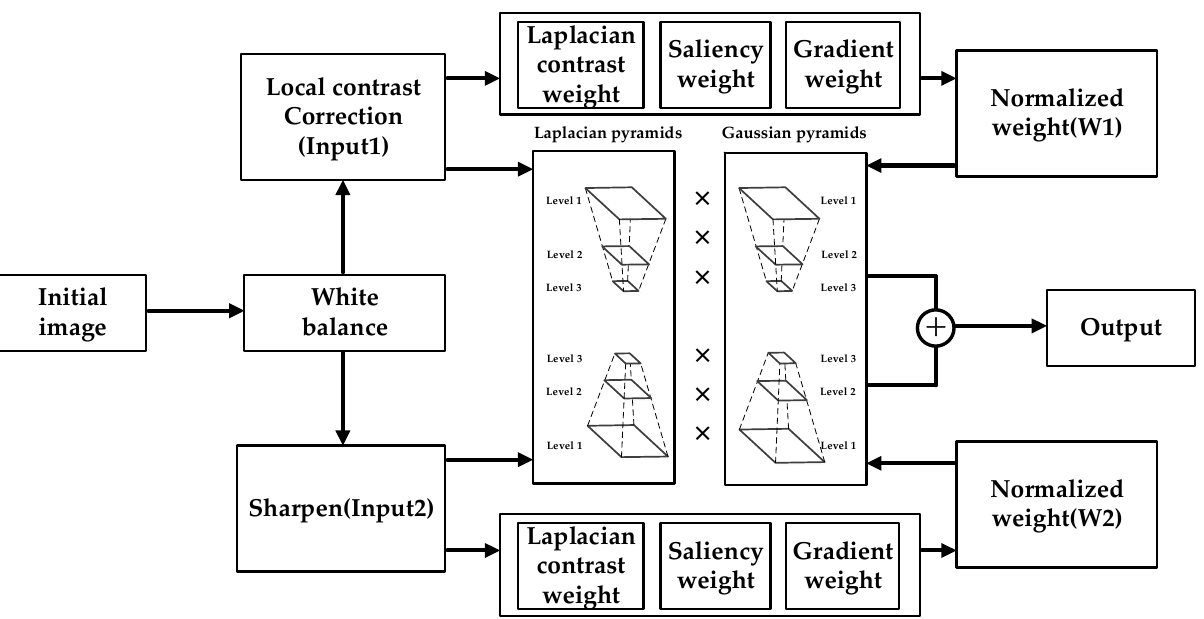
Figure 1. Details of the proposed method. Input1 and Input2 represent local contrast correction (LCC) and image sharping, respectively. These two images are used as inputs of the fusion process. Then, the normalized weight maps are obtained, and multi-scale fusion is carried out on this